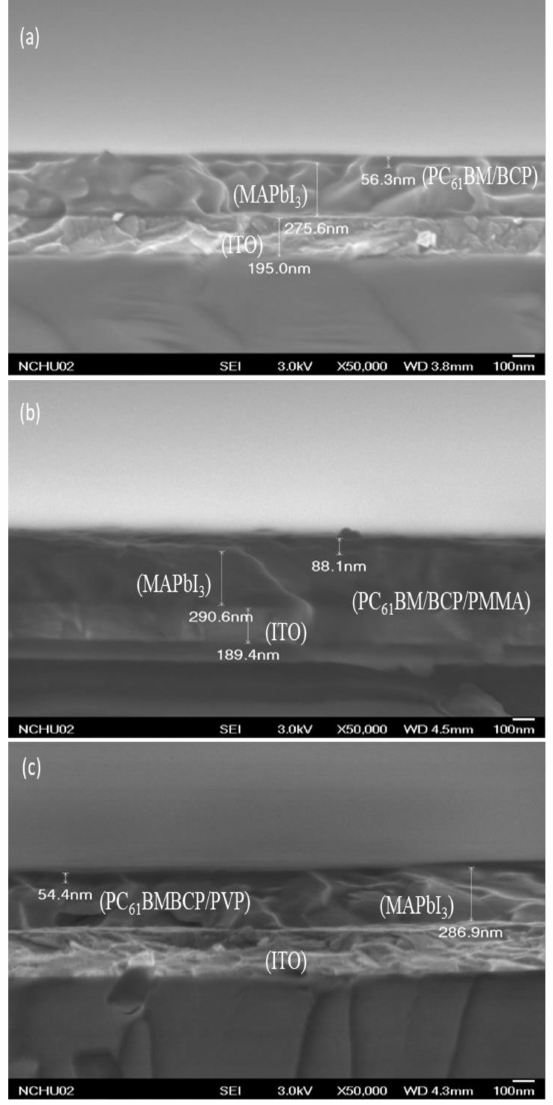
Figure 5. Cross-sectional SEM images of ITO/PEDOT:PSS/MAPbI 3 /PC 61 BM structures coated with hole-blocking/electron-transporting interfacial layers of ( a ) BCP, ( b ) BCP/PMMA (5:1, w / w ), and ( c ) BCP/PVP (5:1, w / w ), recorded after thermal annealing (80 ◦ C, 5